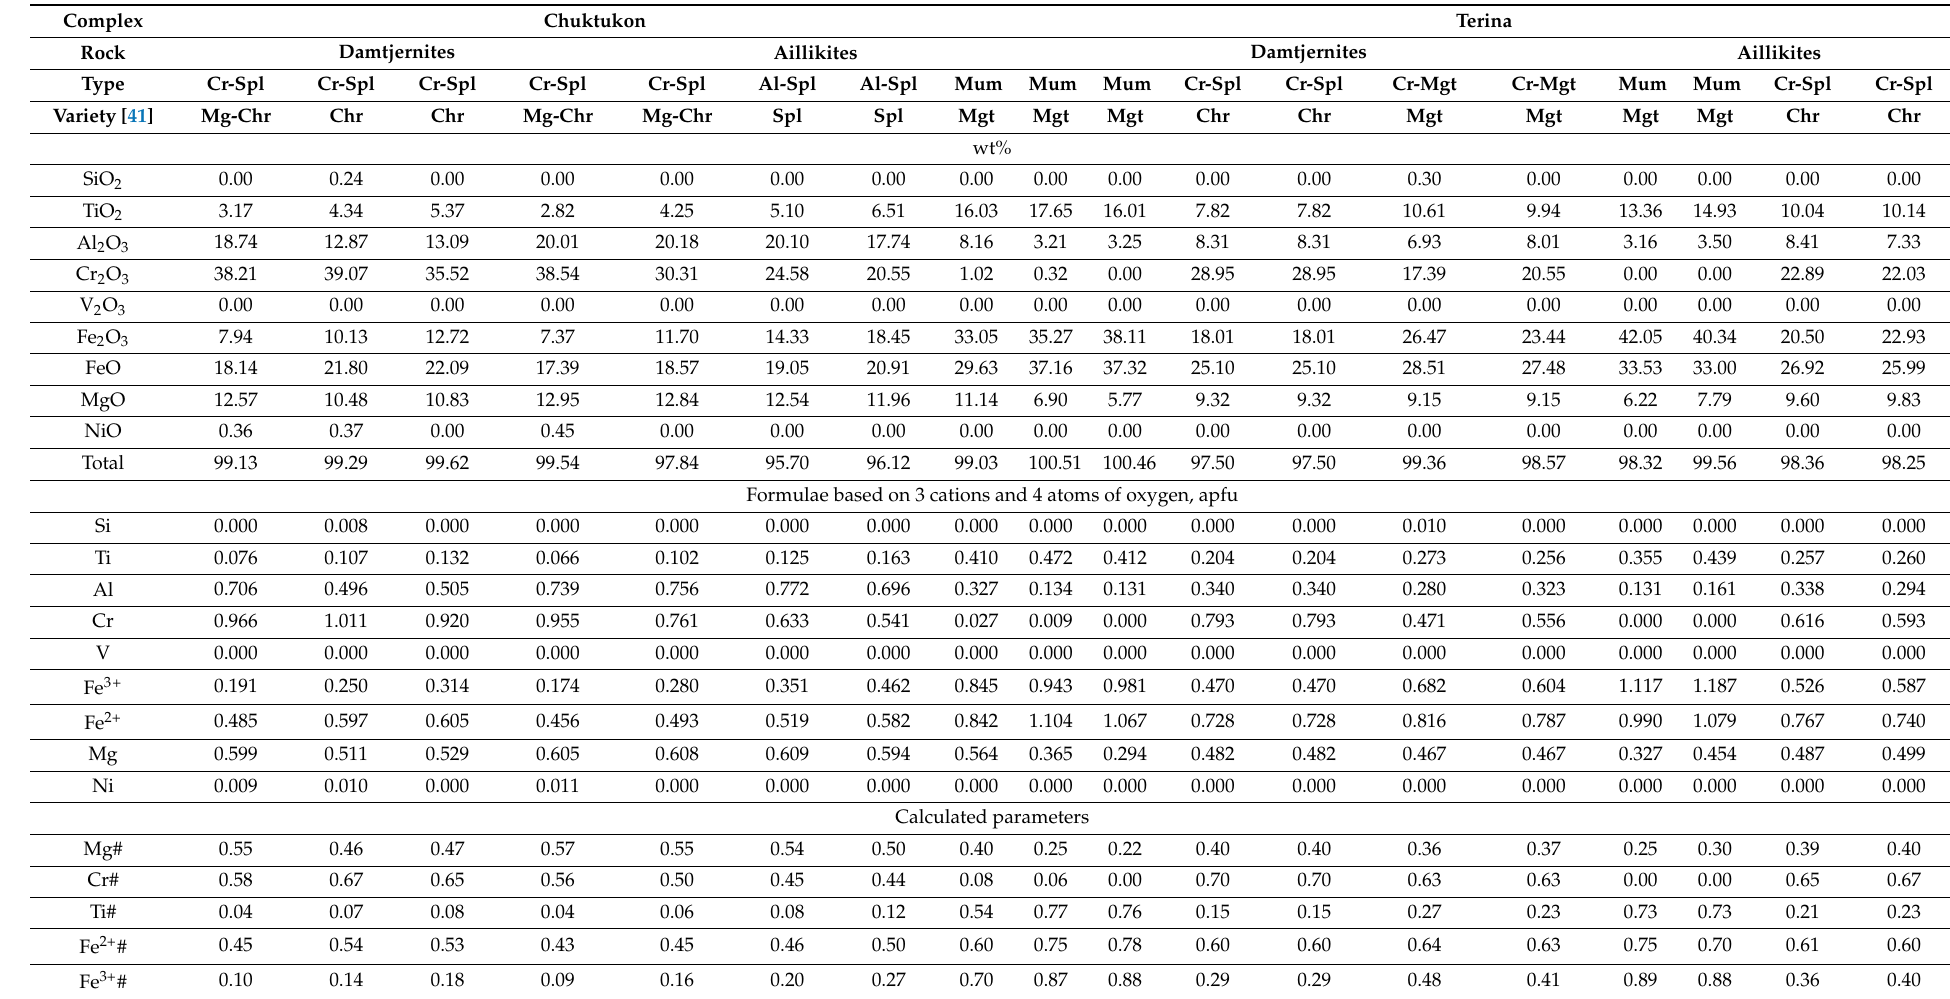
Table 1. Representative chemical composition of the spinel group minerals from the Chdobets ultramafic